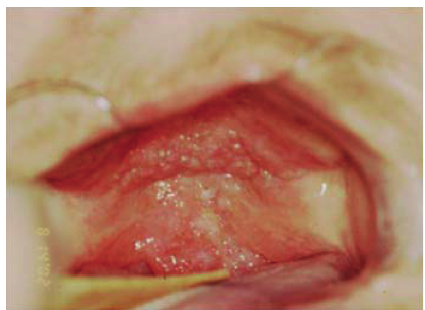
Figure 4: Lesion extending to the